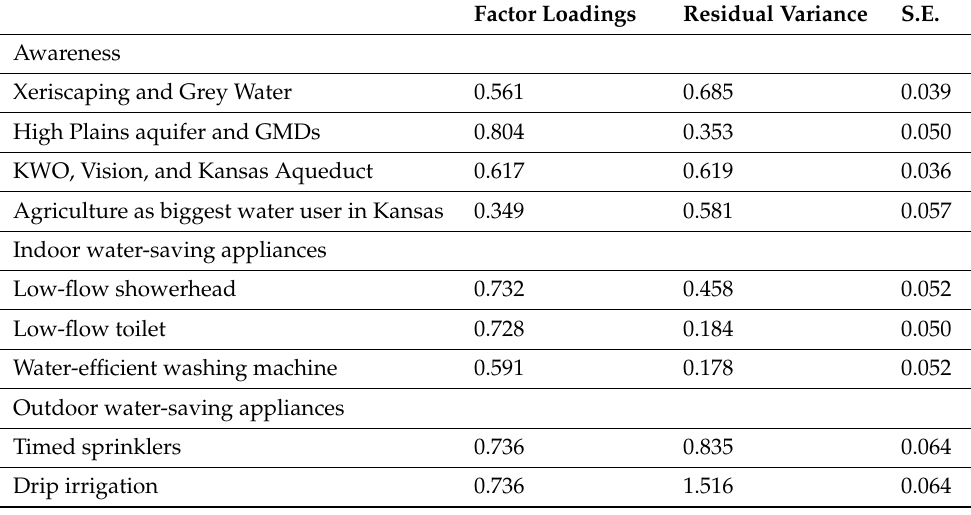
Table A2. Standardized model results of owning water-saving appliances for appliances for indoor and outdoor usage regressed on awareness levels for non-well owners (n =